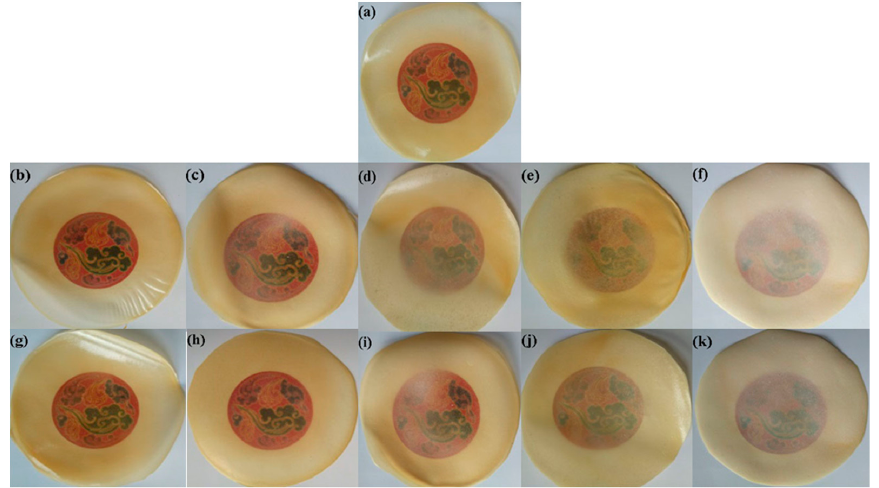
Figure 9. The optical pictures of pure CS membrane ( a ), CS/MAG ( b – f ) and CS/KH550/MAG ( g – k ) hybrid membranes with different quality proportion, with (b–f) and (g–k) both corresponding to CS: MAG = 9:1; 8:2; 7:3; 6:4; 5:5, respectively.